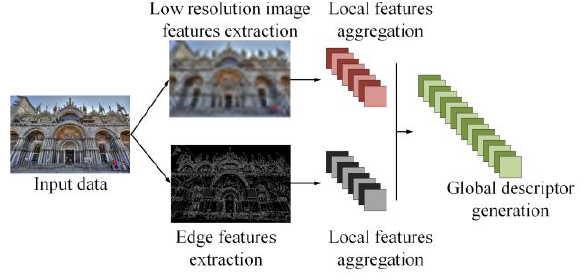
Figure 1. The proposed processing